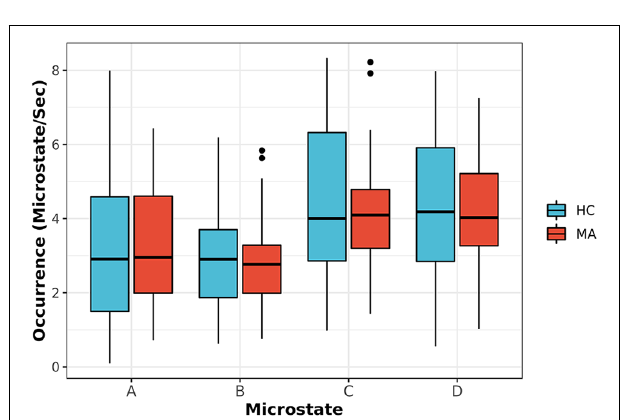
FIGURE 3 | The occurrence frequency of EEG-ms classes (A–D) for both MA and HC groups. For each EEG-ms class, no statistically significant differences among the two groups was